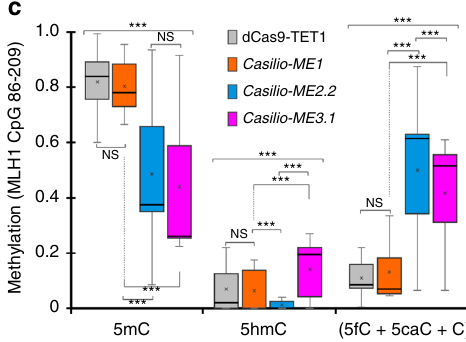
target genes in Casilio-ME2.2 transfected cells